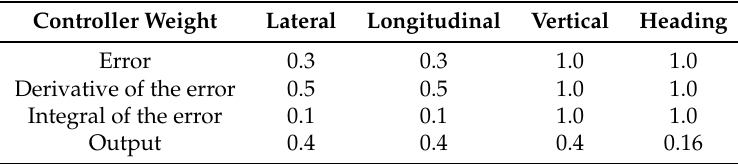
Table 1. Tuned weight values for the four